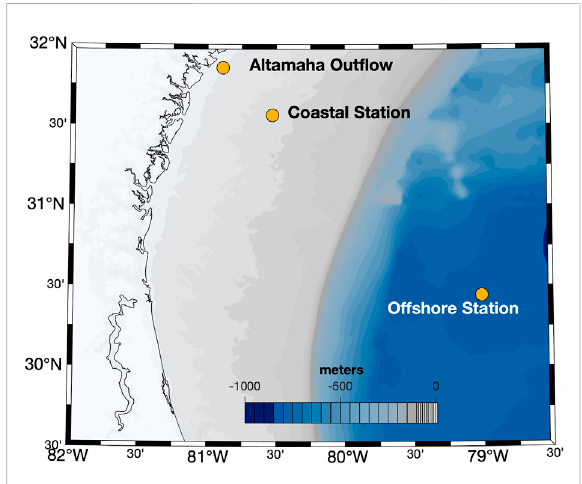
FIGURE 1 Locations of the sampling stations in theSouth Atlantic